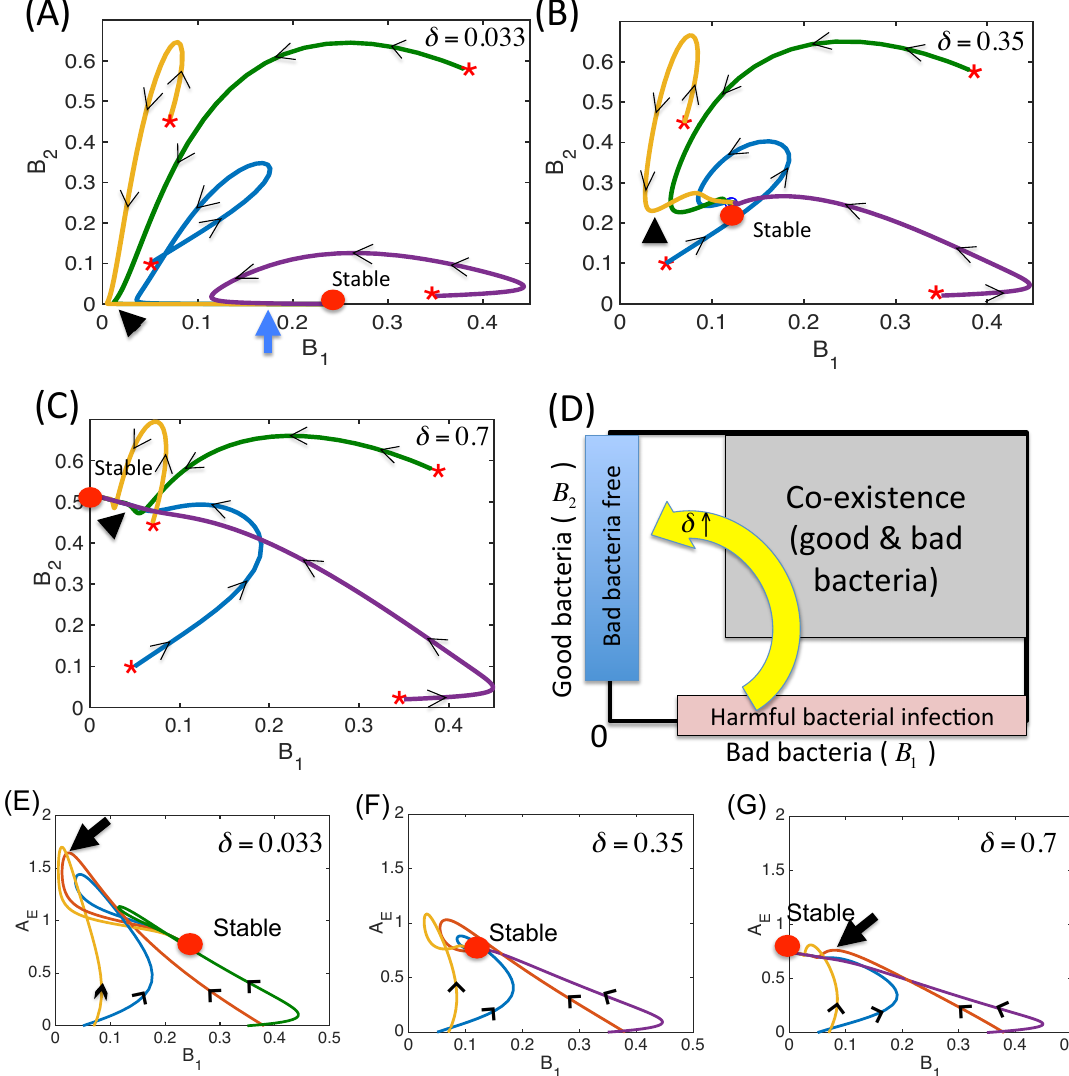
Figure 6. Co-existence and dynamics of harmful and good bacteria in response to various cytokine clearance levels ( δ ) in the competition M2 model (3)–(5). ( A – C ) Trajectories ( B 1 ( t ) , B 2 ( t ) ) of bacterial populations for various decay rates of cytokines ( δ = 0.033 ( A ), 0.35 ( B ), 0.7 ( C )) with